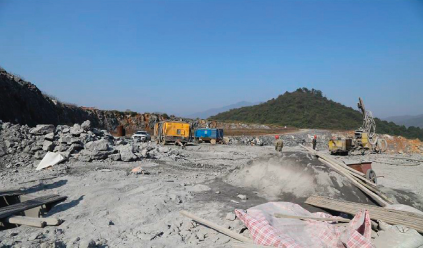
Figure 2: The field experiment site. Table 1: Physical and mechanical parameters of